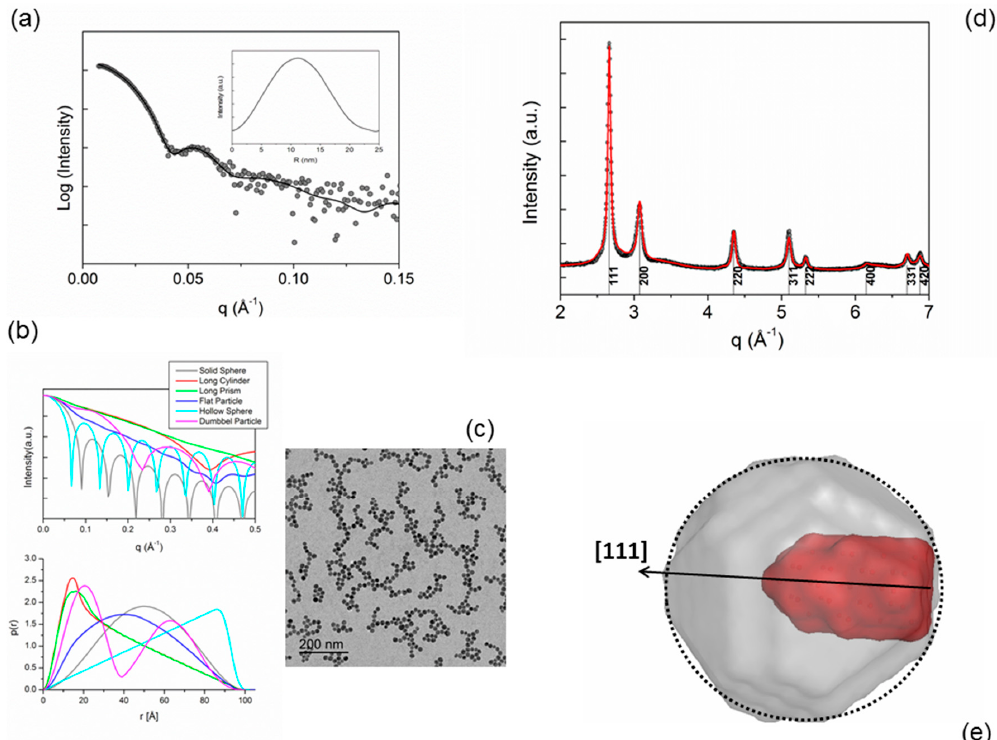
Figure 5. ( a ) SAXS data of silver nanoparticles dispersed in water, with pair distribution function (PDF) of scattering objects with spherical shape (inset); ( b ) SAXS (up) and PDF (down) simulated profiles for scattering objects of different shape (grey: full sphere, red: cylinder, green: prism, blue: disk; cyan: hollow sphere; magenta: dumbbell); ( c ) Transmission electron microscopy (TEM) image of the sample reported in ( a ); ( d ) WAXS data (dotted curve) collected on the sample in ( a ) and the corresponding fitted profile (red line) calculated for the silver crystal structure, ICSD code # 181730, face centered cubic lattice (space group F m ´ 3 m) with a cubic cell of a = 4.086 Å; ( e ) crystalline domain (red colored volume) extracted from WAXS data analysis, reported in scale with respect to the whole nanoparticle spherical size (grey full sphere) extracted from SAXS data analysis. Partially reprinted with permission from reference